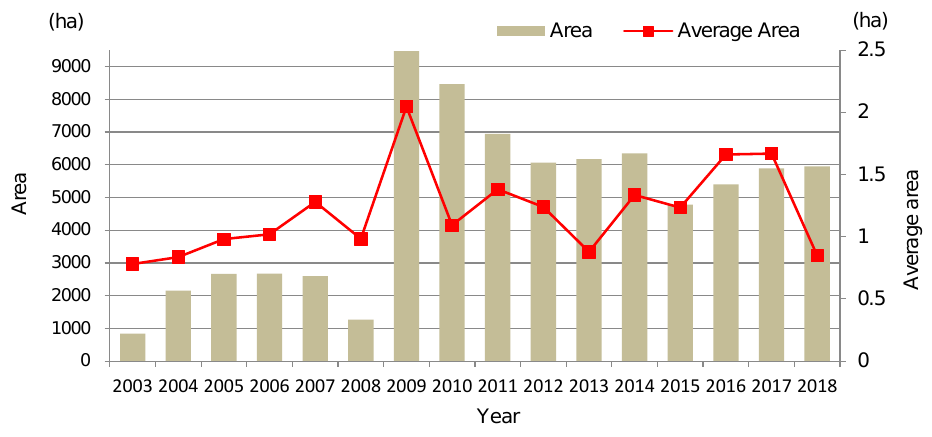
Figure 4. Changes in the area and average area of total landslides over the years in the Laonong River watershed.